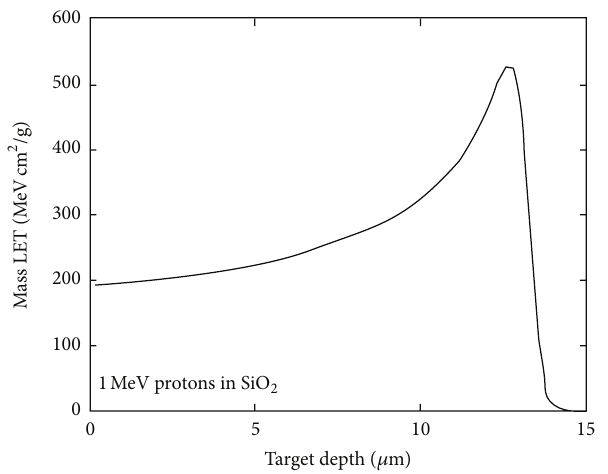
Figure 6: Plot of the mass LET for 1 MeV protons along the depth of a 15 𝜇 m thick silicon dioxide film. The scale of the energy loss axis is linear, in contrast to Figure 1(f) where it is logarithmic.